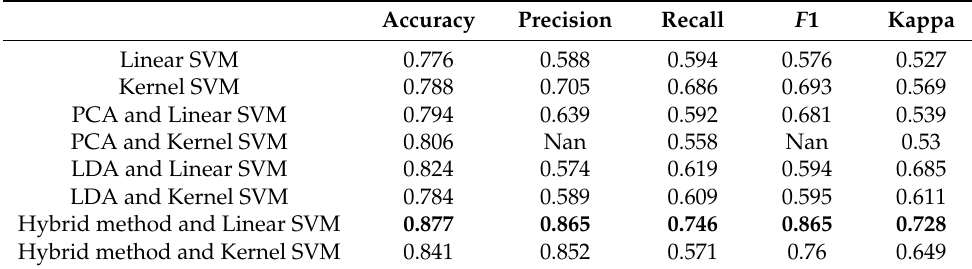
Table 4. Comparison of Different Techniques for the first